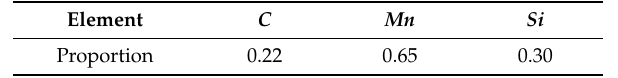
Table 3. The chemical composition of HPB235 reinforcement (mass %).